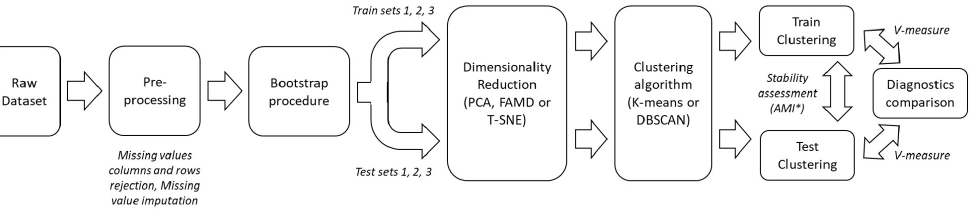
Figure 1. Overview of the processing